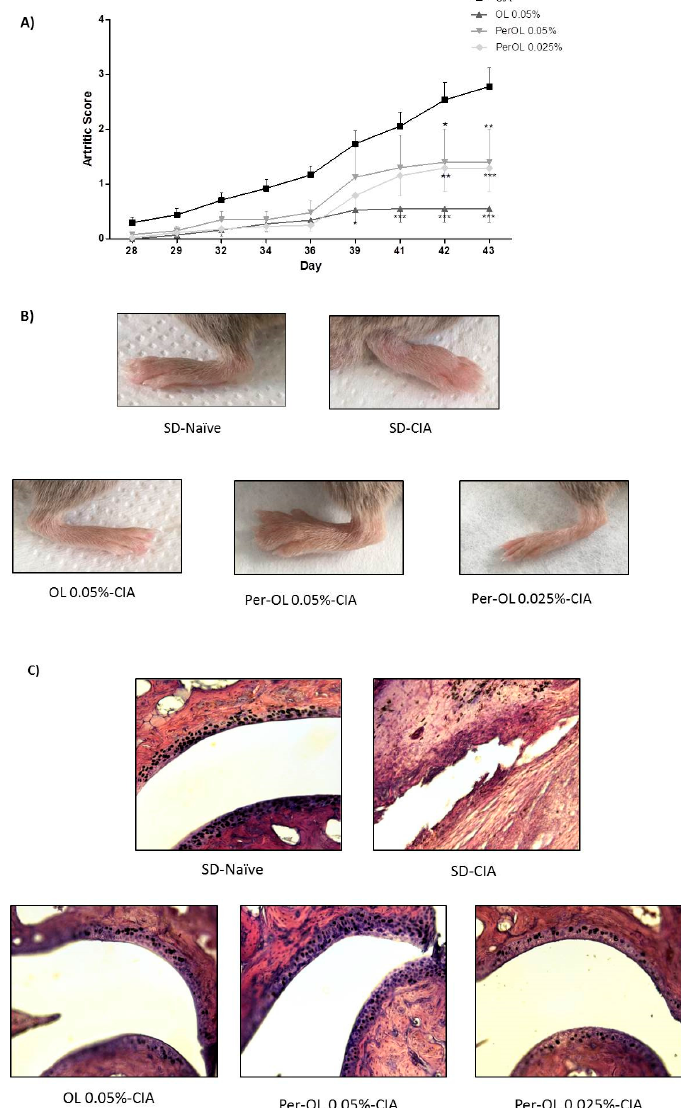
Figure 1. Time course of the arthritis macroscopic score ( A ), representative pictures ( B ) of hind paws at the end of the experiment (day 42). Histological analysis of the sections of knee joints stained with H&E on day 42 ( C ). Original magnification x20. SD-Naïve, non-arthritic mice feed with SD; SD-CIA, control ar- thritic group feed SD; OL 0.05%-CIA, arthritic group feed with enriched-diet with OL 0.05% w / w and Per-OL 0.05% and 0.025%, arthritic group feed with enriched-diet with Per-OL 0.05 and 0.025% w / w, re- spectively. Pictures show less damage at the cartilage. The images are representative of at least five ex- periments. Data represent mean ± S.E.M. n = 12. * p < 0.05; ** p < 0.01 and *** p < 0.001 vs. SD-CIA control group.